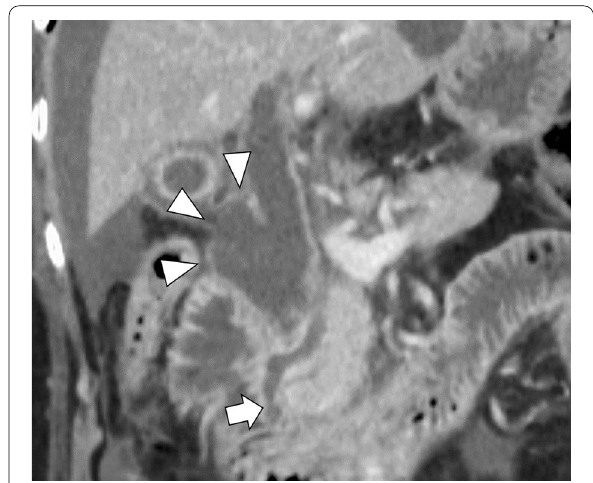
Fig.2 Preoperative computed tomography (coronal view). The common channel of the pancreaticobiliary duct (arrow) was long at 9.3 mm in length and seemed to be joined outside the muscular layer of the duodenal papilla on the enhanced computed tomography